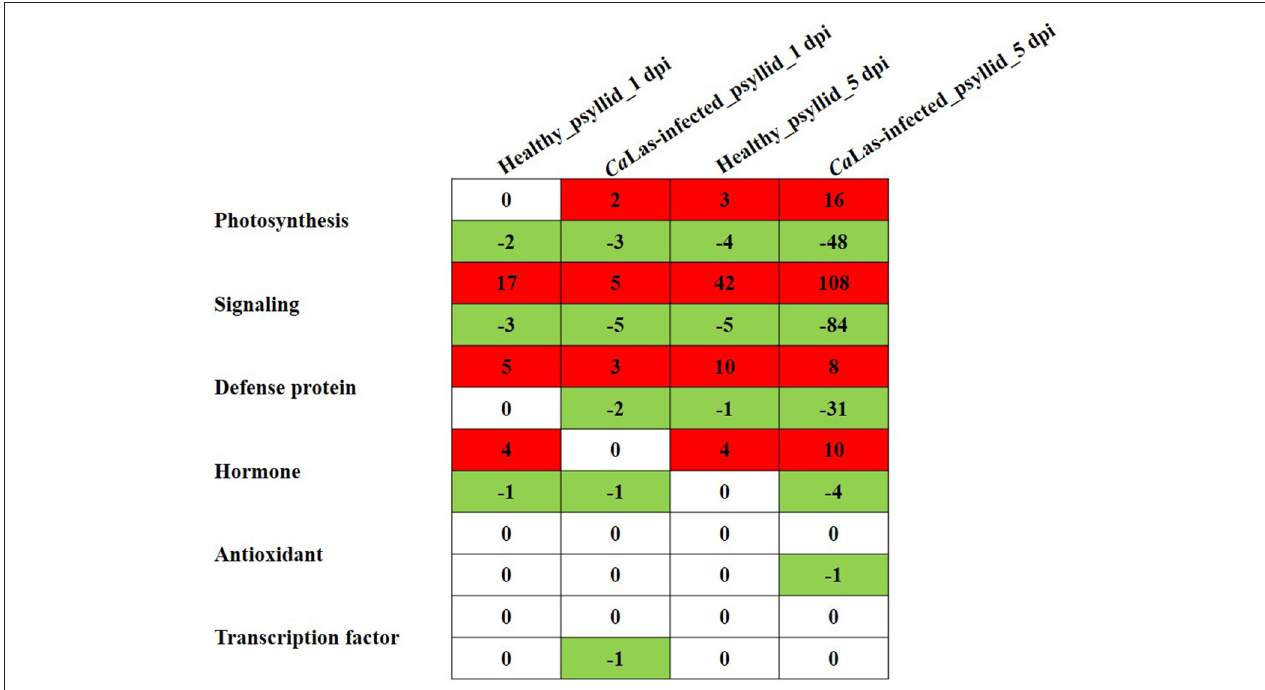
FIGURE 8 | The number of DEGs involved in photosynthesis, signaling, hormone, defense protein, transcription factor, and antioxidant pathways detected in VAL at 1 and 5 days post healthy psyllid and Ca Las-infected psyllid infestation, which require ATP/GDP/GTP and phosphate for function. Cells colored in red represent upregulated DEGs and cells colored in green represent downregulated